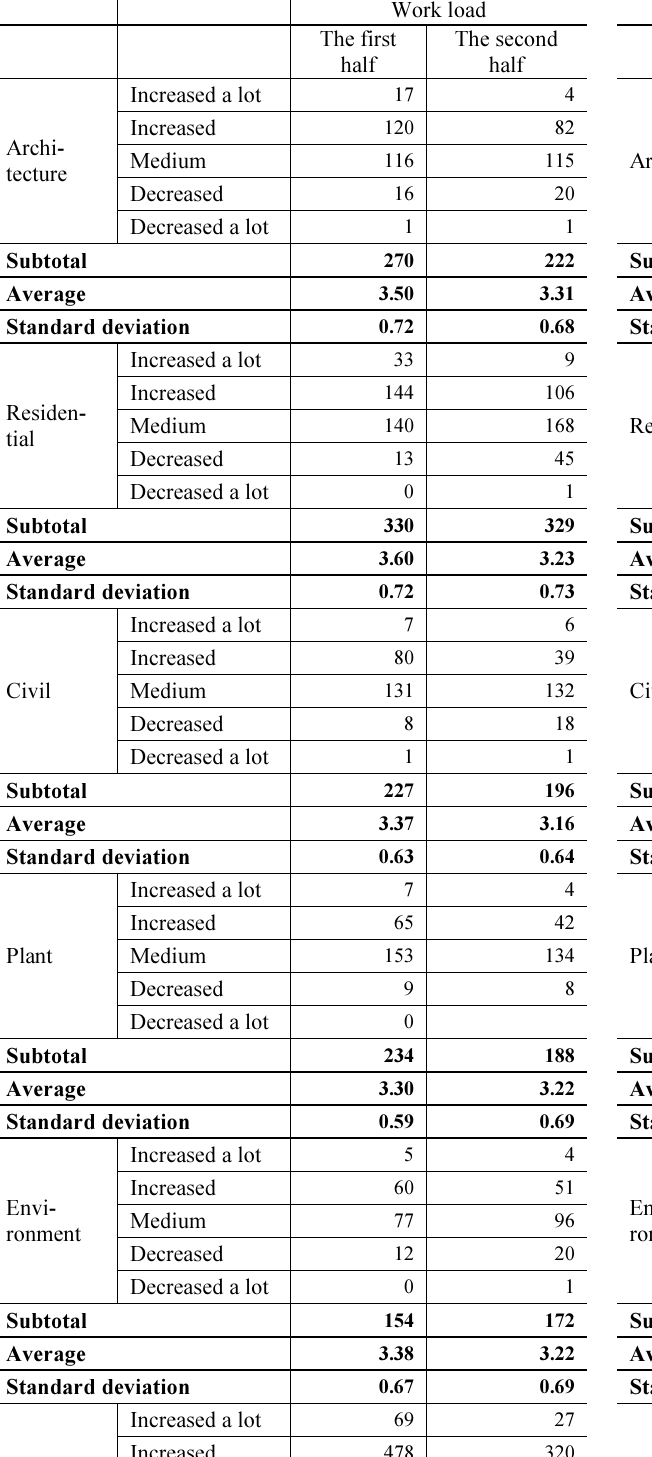
Table 3. Workload of the proposed system Table 4. Efficiency of the proposed